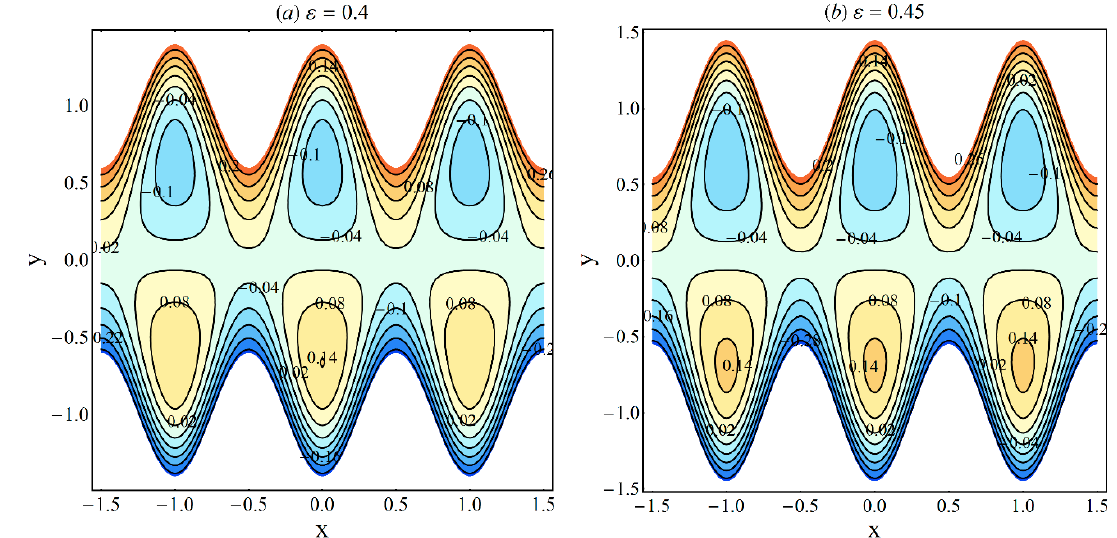
Figure 30. Streamlines at two different values of ε , when α = 0.2 , ϕ = 0.01 , β = 0.5 , ξ = 0.02 , η = M = 1, Q = 0.4: ( a ) ε = 0.4; ( b ) ε = 0.45.